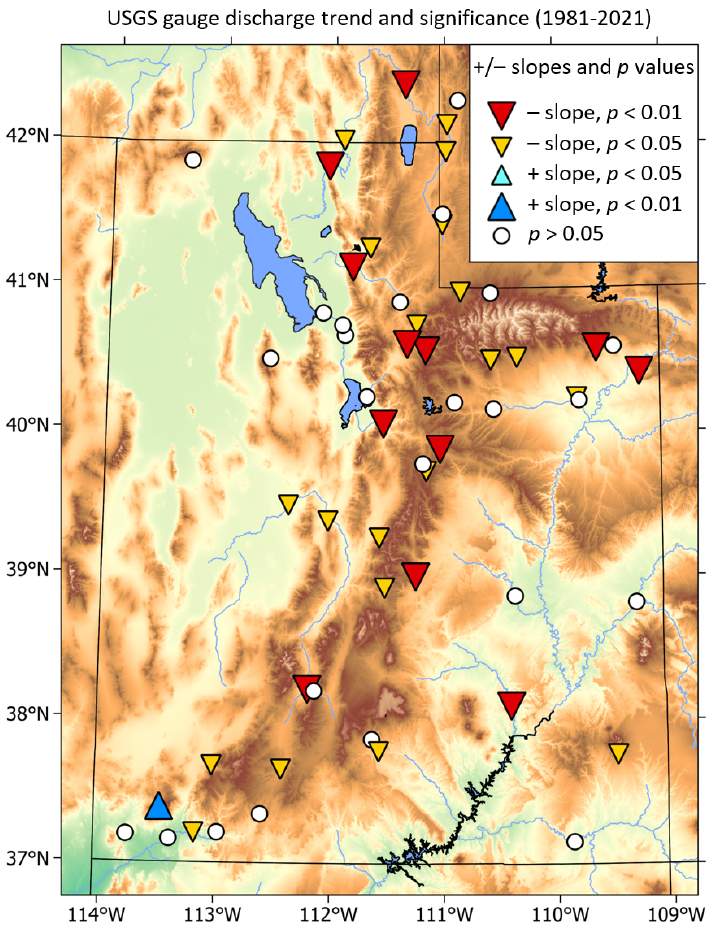
Figure 1. Trend of discharge and statistical significance from 1981–2021 for the 65 USGS gauges used in this study. Triangles represent the sign of slope with size denoting significance levels.